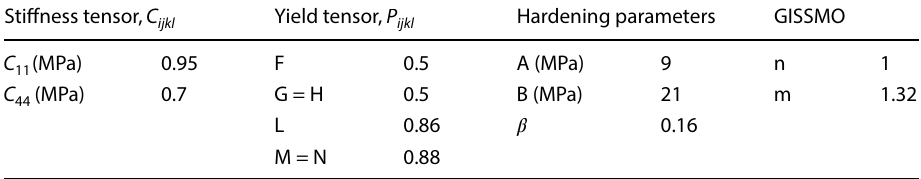
Stiffness tensor, C ijkl Yield tensor, P ijkl Hardening